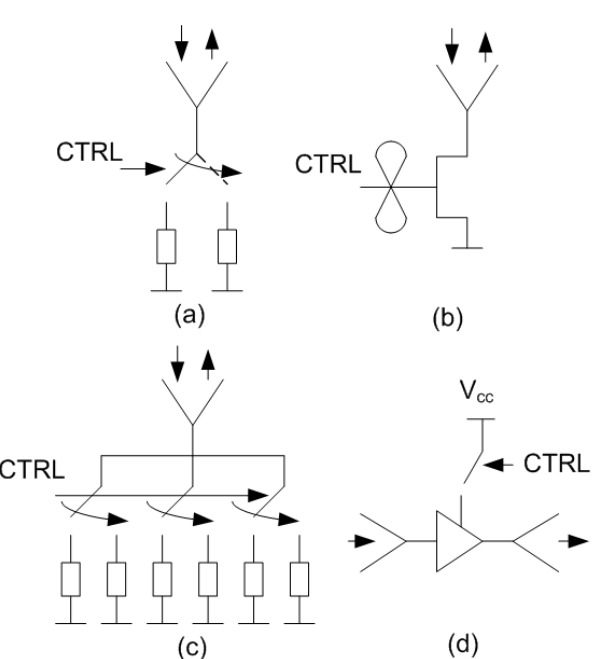
Figure 17. Common mm-wave backscatter topologies: ( a ) backscatter based on a switch, ( b ) backscat- ter based on a Cold-FET, ( c ) retrodirective backscatter and ( d ) transponder using an